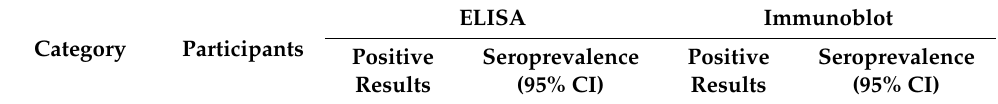
Table 3. SARS-CoV-2 infection risk